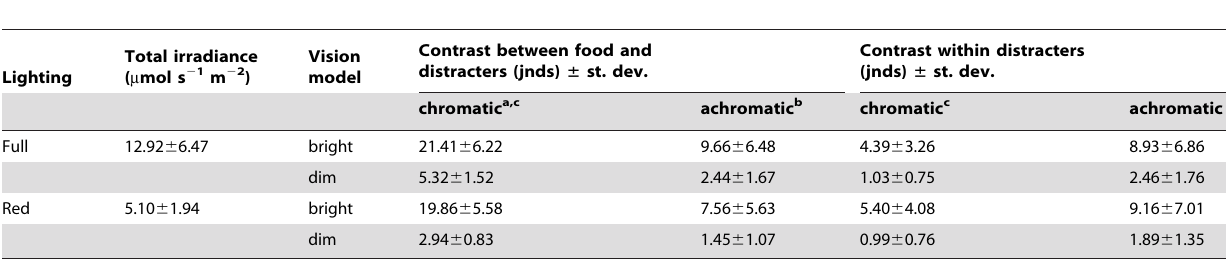
Table 1. Total irradiance and predicted visual contrasts between food pellets and background distracters under experimental illumination modeled assuming either bright or dim (photon-noise limited)